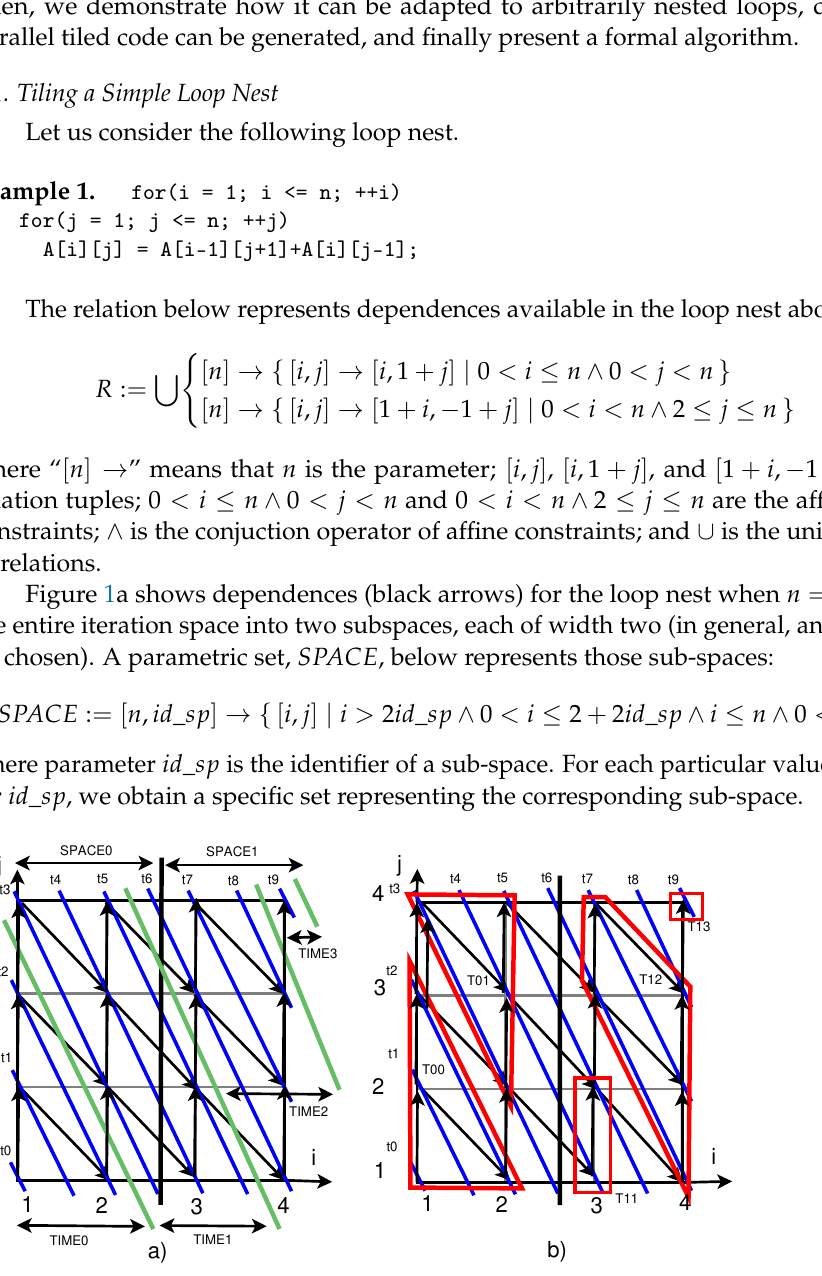
Figure 1. Spaces and tiles. ( a ) Spaces and time slices; ( b ) Target tiles. In Figure 1a, the black vertical line divides the entire iteration space into two subspaces, SPACE 0 and SPACE 1, defined with parameters id _ sp = 0 and id _ sp = 1,